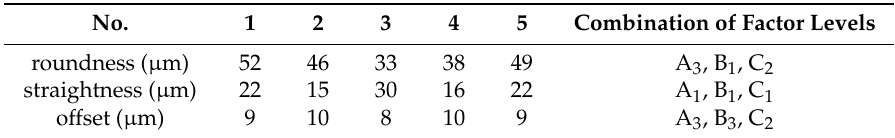
Table 6. Measured results of three